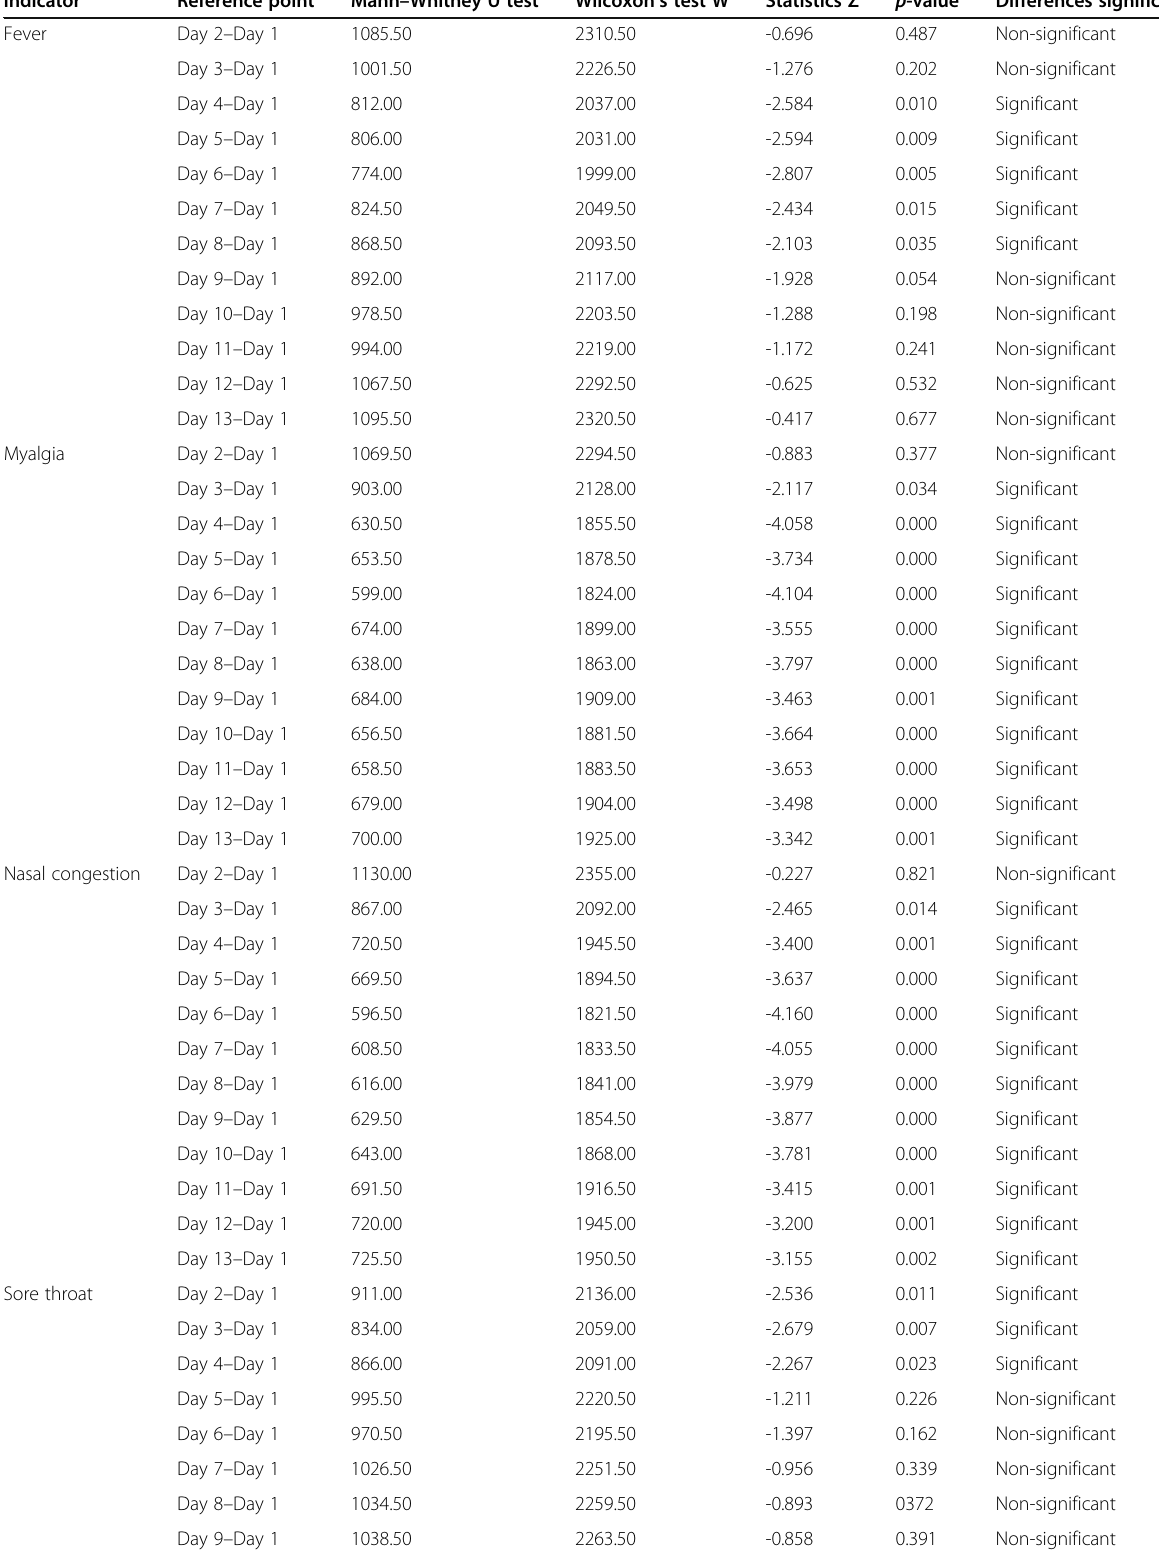
Table 5 Comparison of the symptoms dynamics in the observation groups according to the self-assessment (Mann-Whitney U test)